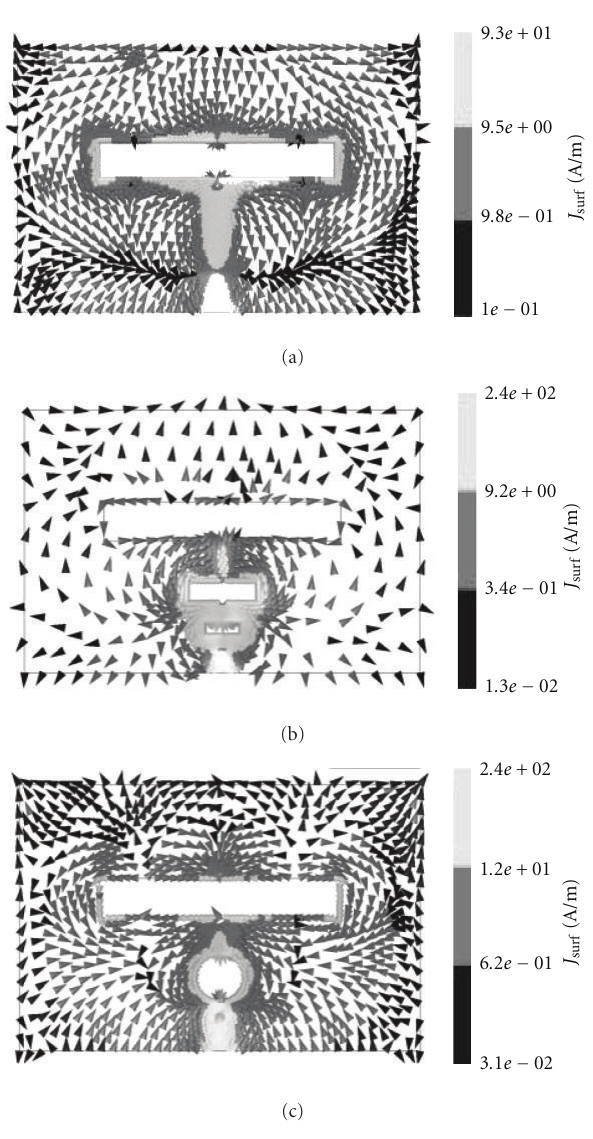
Figure 4: Simulated current distribution on the ground plane at the third harmonic frequency for (a) conventional slot antenna, (b) RDGS slot antenna, and (c) CDGS slot